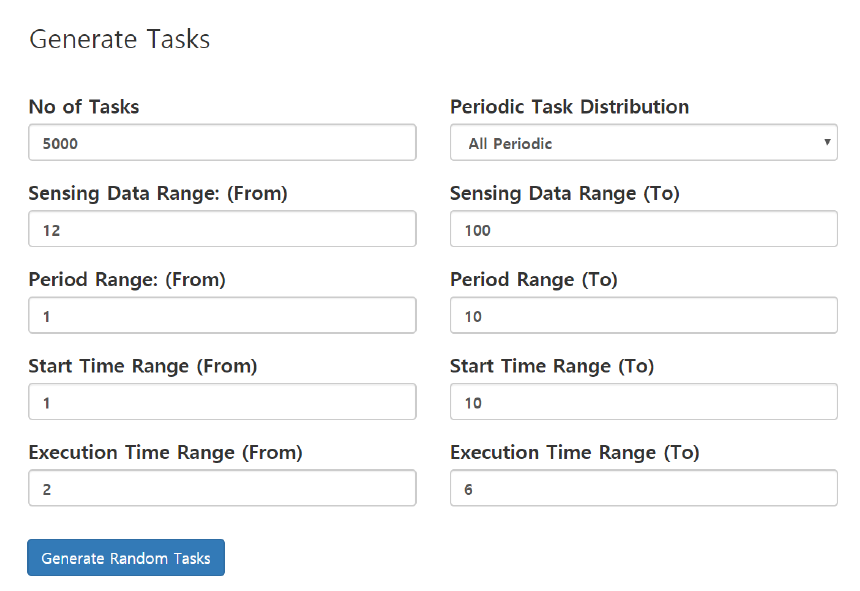
Figure 4. Sensor task creation generation